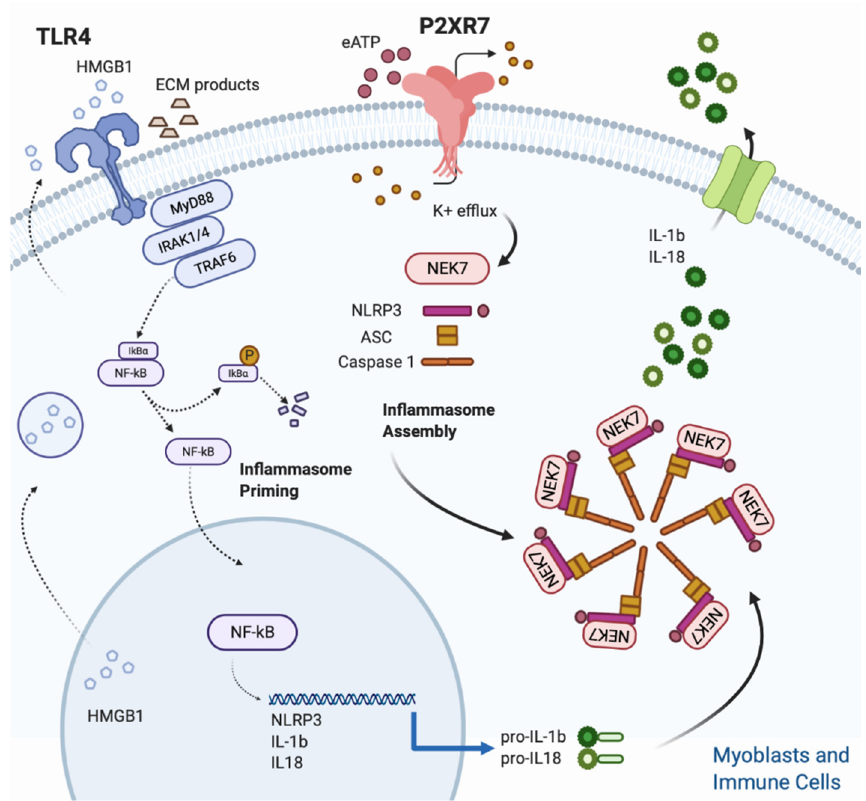
Figure 1. NLRP3 inflammasome activation in skeletal muscle. Skeletal muscle cells are equipped with a functional inflammasome pathway and actively participate to the inflammatory response upon P2X7R stimulation. A two signals model is proposed for NLRP3 inflammasome activation. The Inflammasome priming (first step) is triggered by TLR 4 which in turn is activated upon binding with its cognate ligands such as extracellular matrix degradation (ECM) products and high mobility group Box 1 ( HMGB1). HMGB1 is a nuclear protein that acts as a DNA chaperone in the nucleus and as a signal of tissue damage when extracellularly released. Ligand binding and conformational change that occur in the receptor lead to the recruitment of the adaptor protein MyD88, which in turn recruits IRAK4, IRAK1 and IRAK2. IRAK kinases then phosphorylate and activate the protein TRAF6, resulting in I κ B α degradation and NF- κ B diffusion into the cell nucleus. The nucleus of NF κ B activates the transcription of NLRP3, IL-1 β and IL-18. The inflammasome assembly (second step) is triggered by the eATP/P2XR7/K + efflux. In particular, intracellular K + efflux, caused by opening of plasma membrane channels (P2X7R included), induces the assembly of the fully active NLRP3 complex (NLRP3-ASC-NEK7-Caspase-1). Finally, caspase-1, cleaves the pro-IL1 β and pro IL-18 into their mature forms.